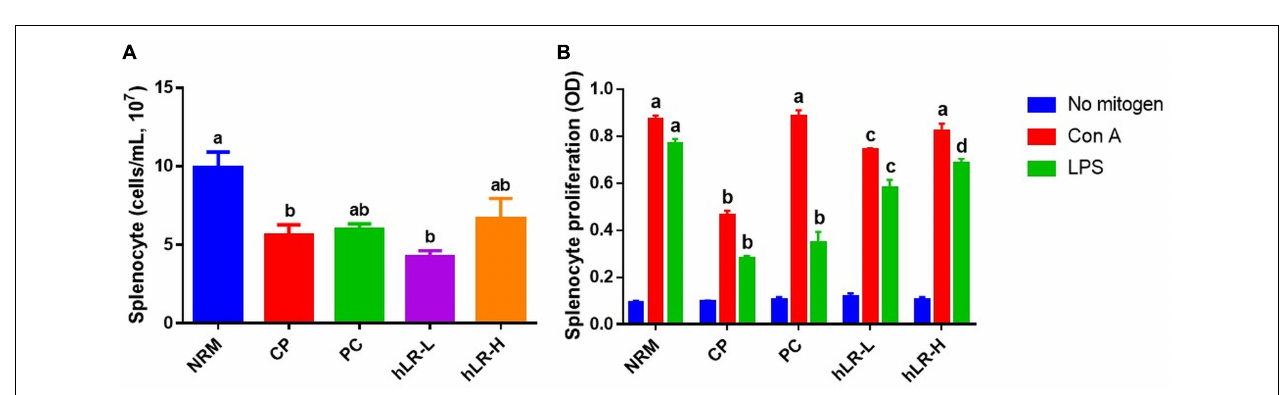
FIGURE 5 | Effects of hLR on immune blood cell counts of CP-treated immunosuppressed mice. Number of WBCs (A) , lymphocytes (B) , MID (C) , and granulocytes (D) . Data are the mean ± SEM ( n = 8). Different letters above the bars indicate a significant difference between the groups ( p < 0.05).